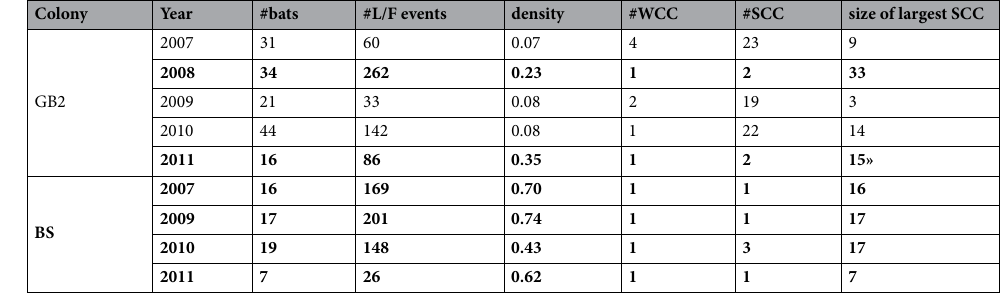
Table 4. Topological characteristics of the leading-following networks from the GB2 and BS colonies. Shown are number of bats (nodes), number of identified L/F events (links), network density, number of weakly connected components, number of strongly connected components, and the size of the largest strongly connected component. Rows in bold are the dataset we consider for further